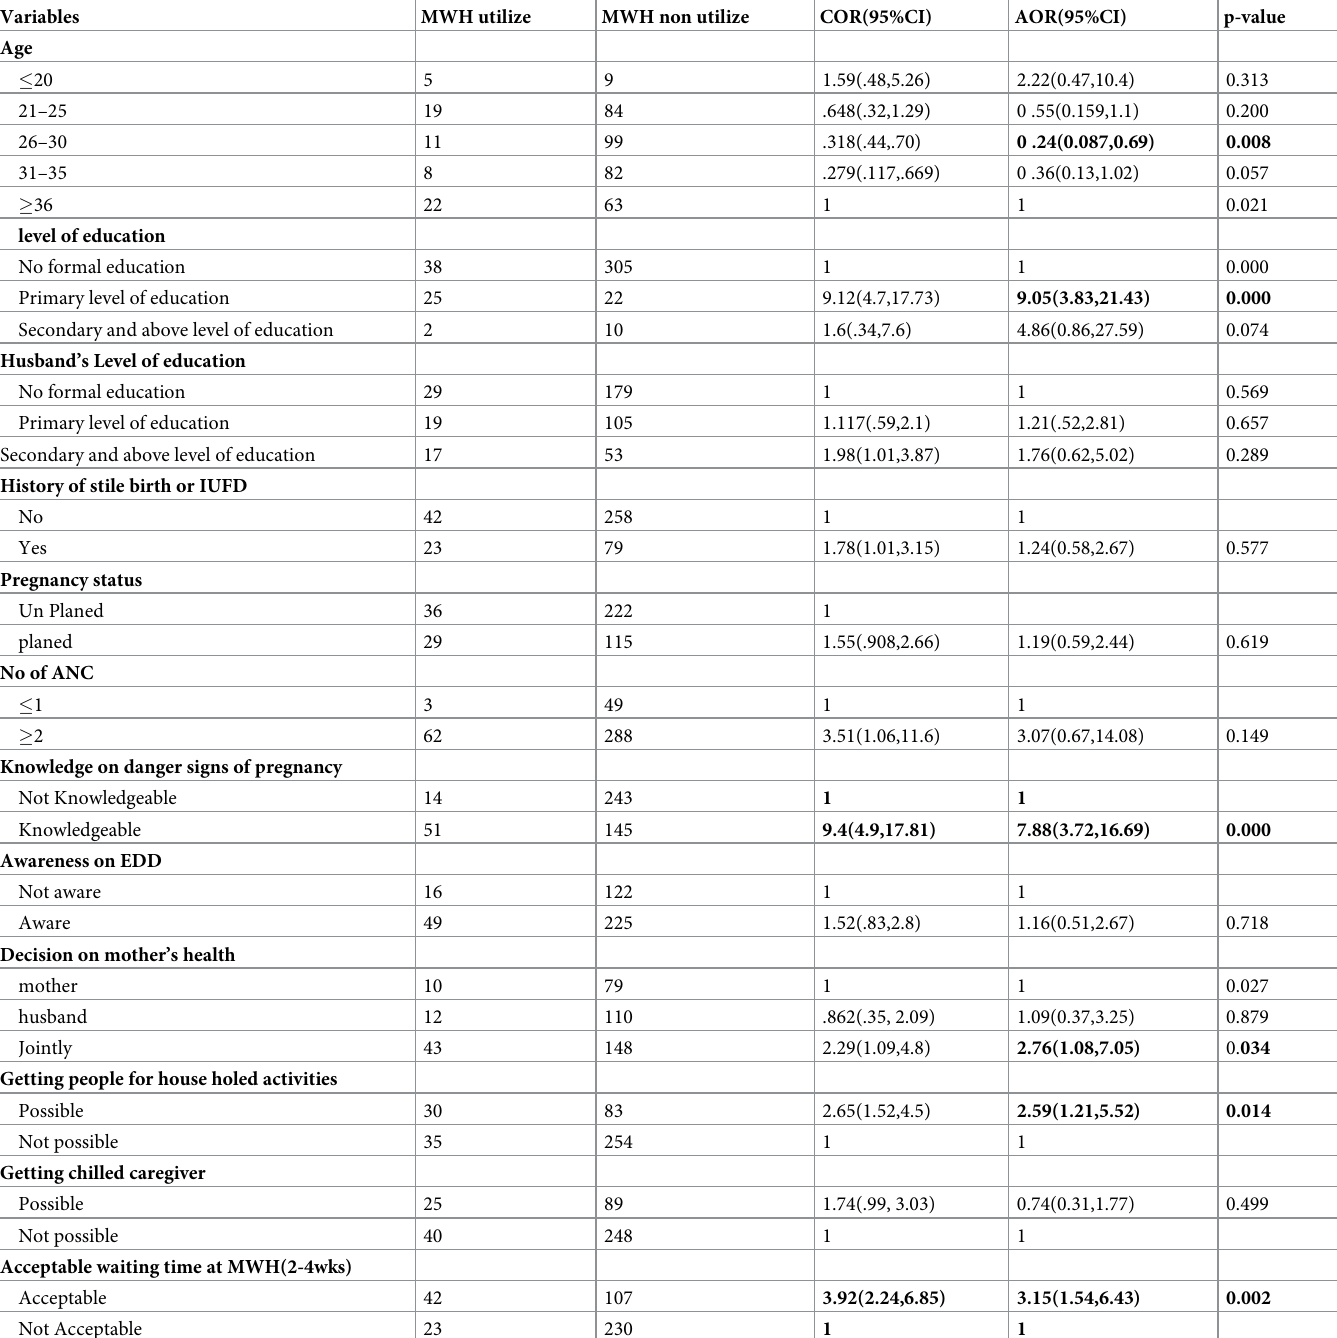
Table 4. Factor associated with maternal waiting home utilization, Dabat district, north west Ethiopia,